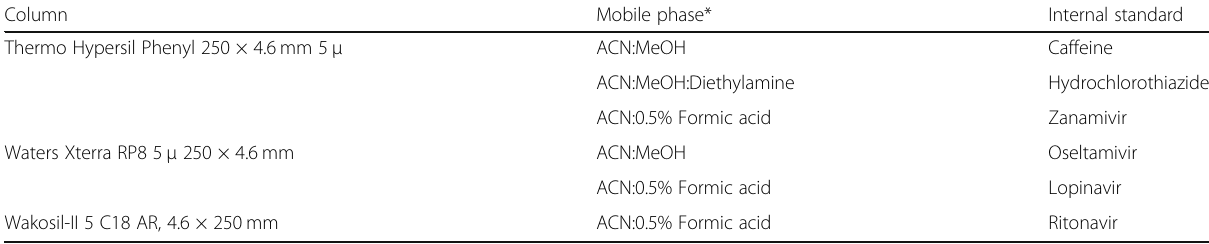
*Mobile phase components were at different